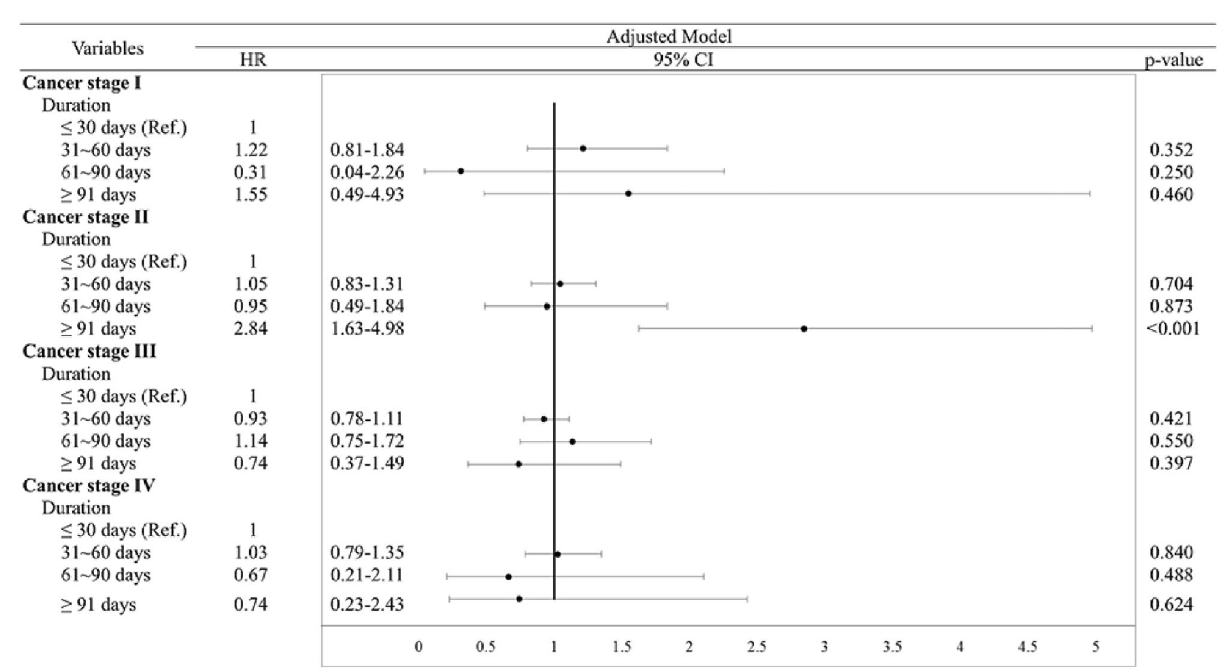
Figure 1. Influence of DFTI on mortality risk in patients at various breast cancer stages. The related variables (age, marital status, education level, monthly salary, level of urbanization, CCI score, tumor size, number of involved lymph nodes, hormone receptor status, HER2 status, treatment type, hospital level, and hospital ownership) were controlled in each